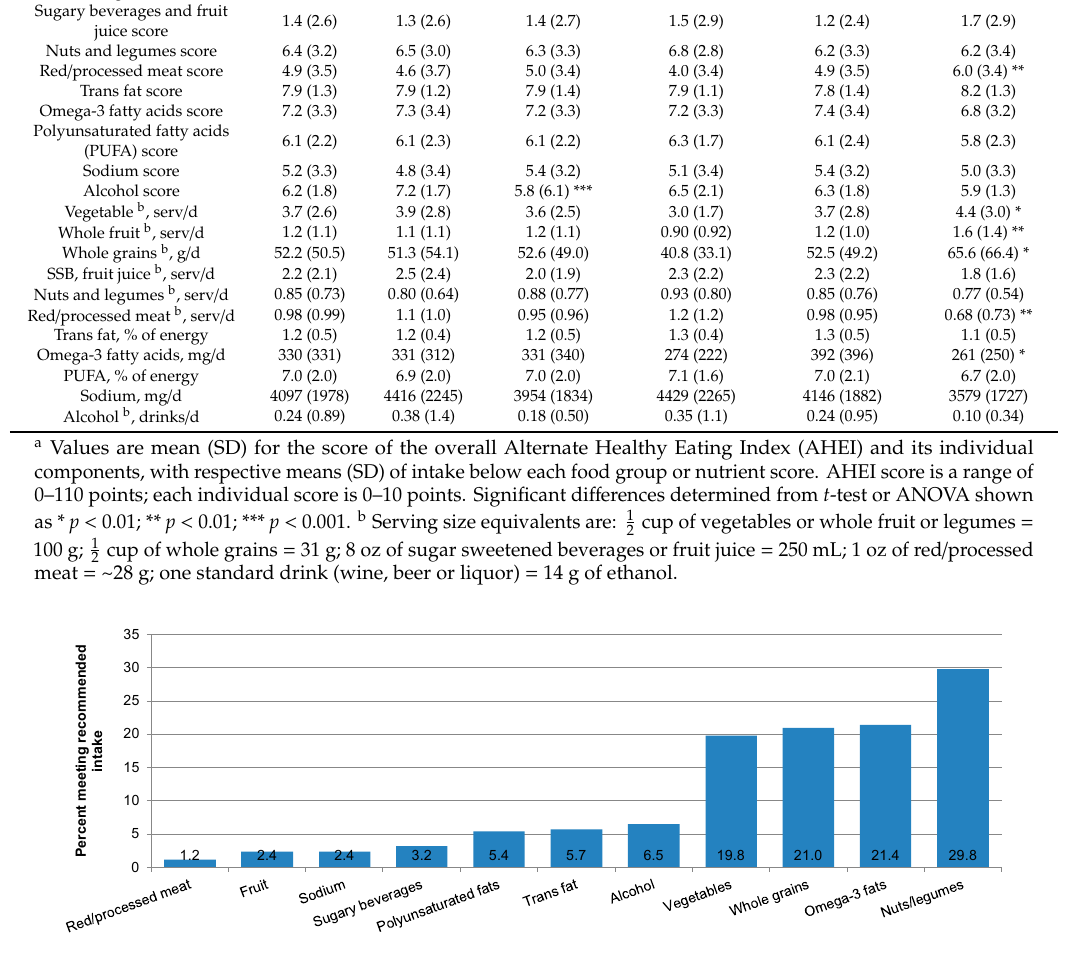
Figure 1. Percent of adults living in Puerto Rico meeting the recommended intake of food and nutrient components of the Alternate Healthy Eating Index.